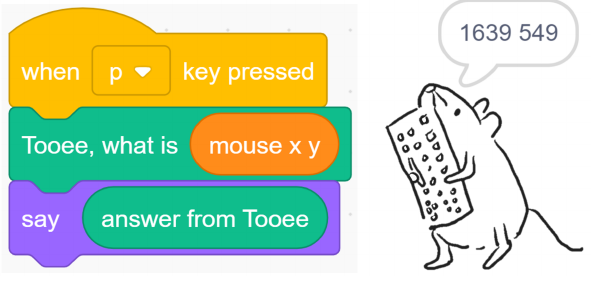
Figure 5. Example code to discover the current mouse cursor coordinates for mouse automation.